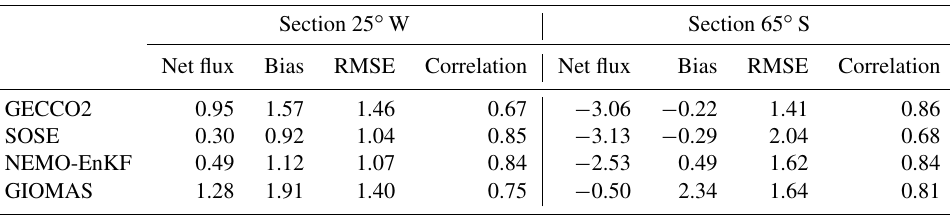
Table 4. Mean sea-ice volume flux biases, root mean square error and correlation through the 25 ◦ W and 65 ◦ S sections between the four reanalyses and satellite observations. (Unit: 10 3 km 2 month − 1 ; positive/negative sign means the outflow and inflow into the regions outlined by red and blue lines in Figs. 8 and 9.)